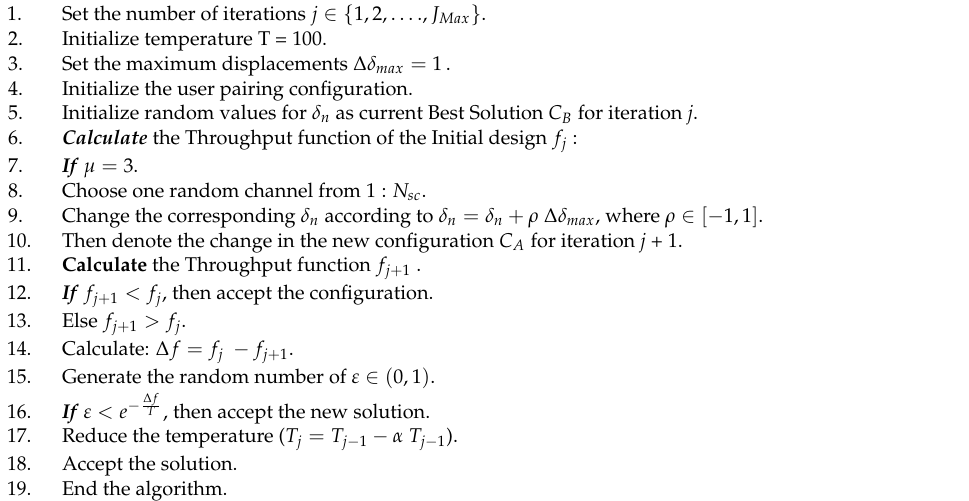
Algorithm 3: Proposed SA-based proportional Power Scheme.